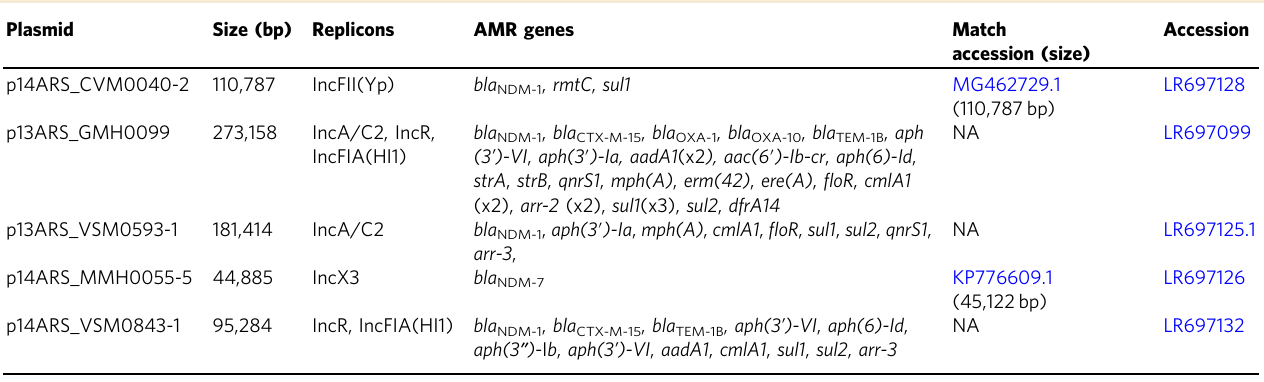
The replicons and AMR genes were identi fi ed with the PlasmidFinder and ResFinder databases, respectively. The match accession indicates the accession code when at least one match of more than 90% query sequence coverage and 99% identity was found in the NCBI nucleotide database. NA not